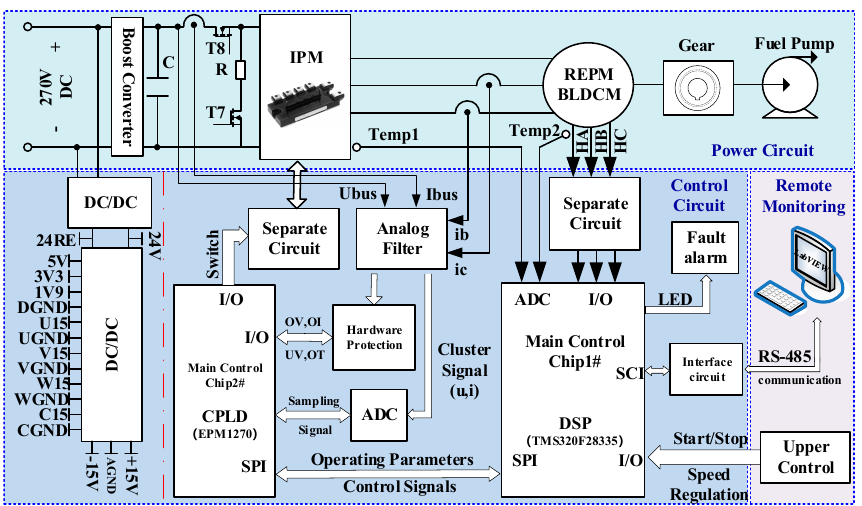
Figure 4. Control block diagram.